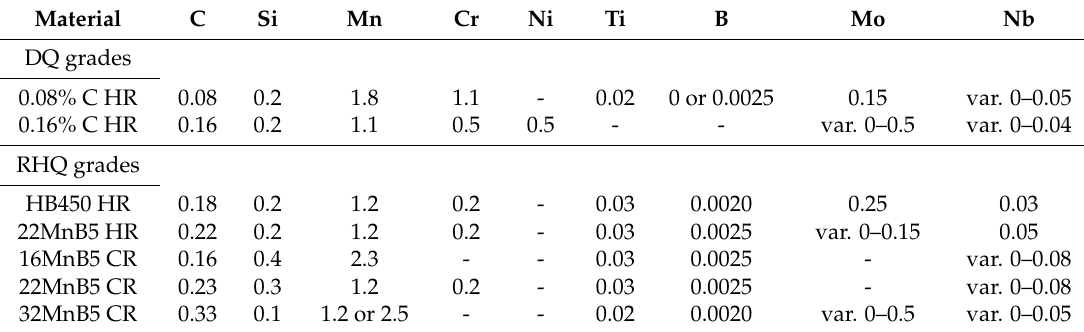
Table 1. Chemical composition in wt % of hot rolled (HR) and cold rolled (CR) direct quenched (DQ) and re-heat quenched (RHQ) steels analyzed in this